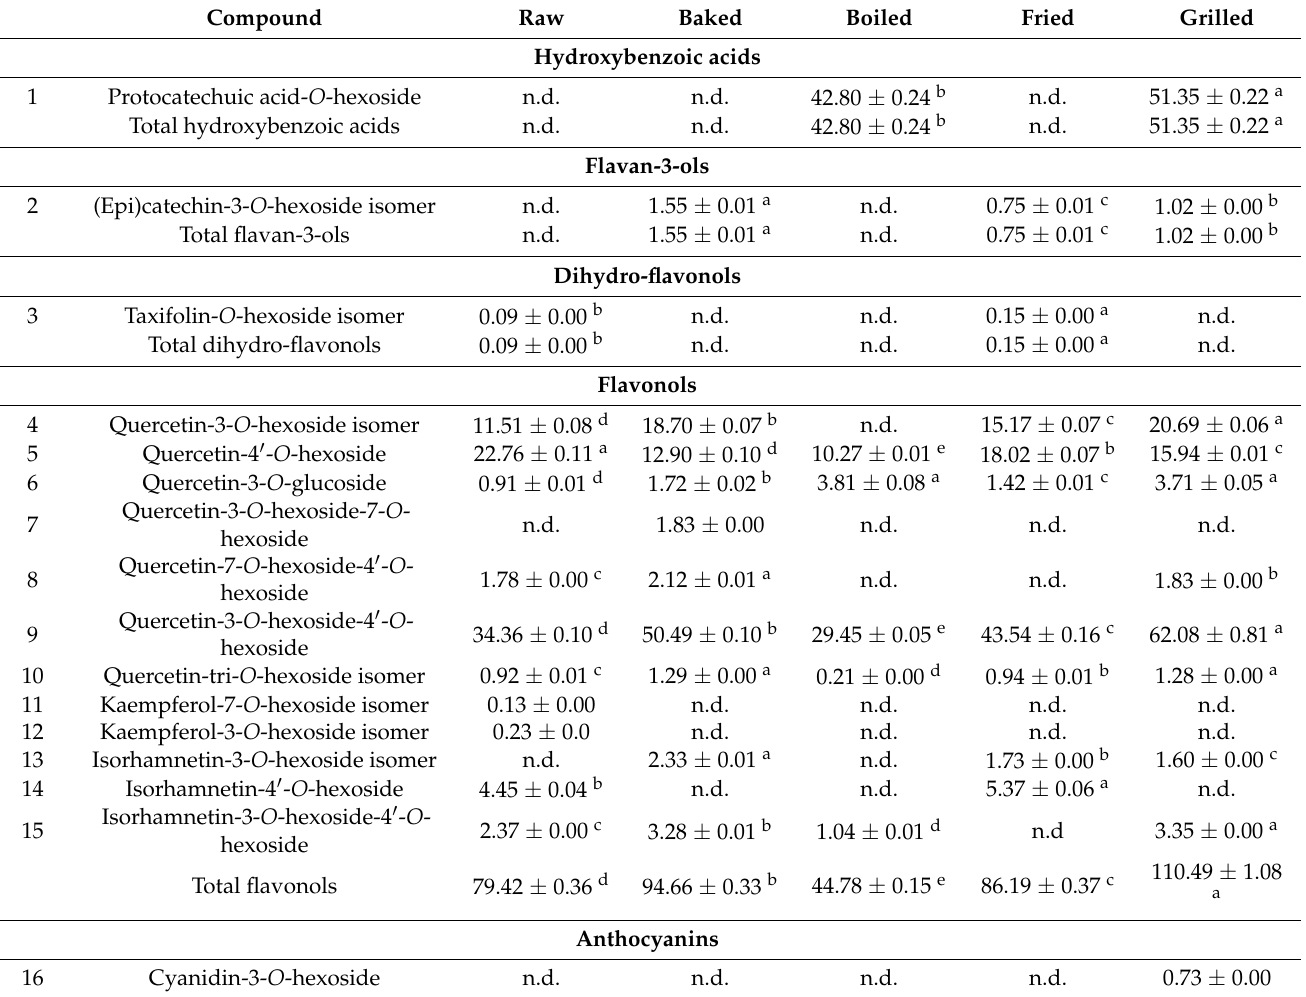
Table 2. Concentration of phenolic compounds in in vitro digested raw and cooked red-skinned onion phenolic-rich fractions. Results are reported as µ mol of phenolic compounds/100 g of raw or cooked onion. In Vitro Digested Red-Skinned Onion Phenolic-Rich Fractions Compound Raw Baked Boiled Fried Grilled Hydroxybenzoic